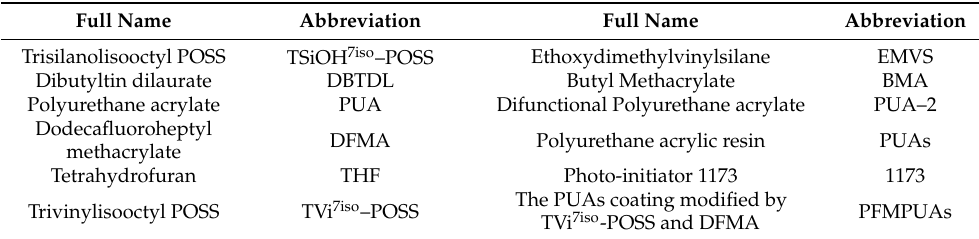
Table 1. Full name and abbreviation contrast